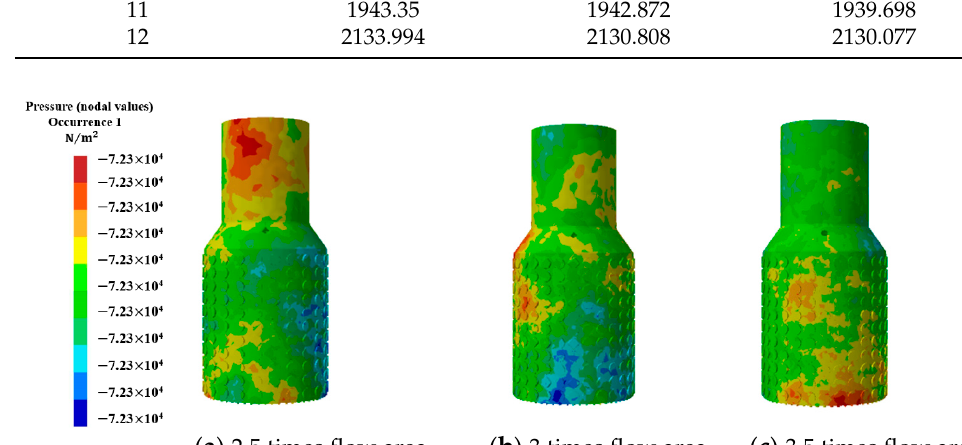
Figure 20. First-order acoustic cavity modality.